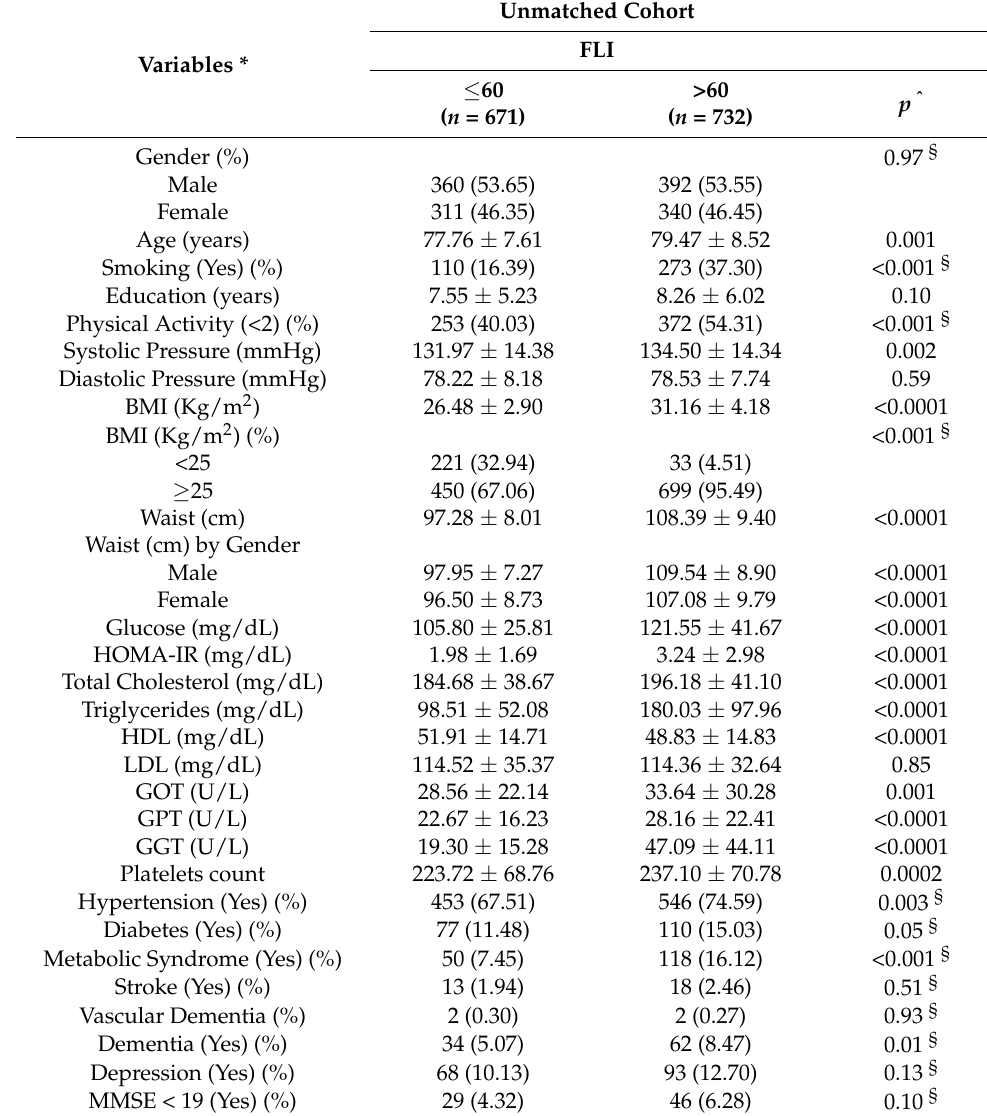
Table 1. Baseline and clinical characteristics of patients in the unmatched cohort.